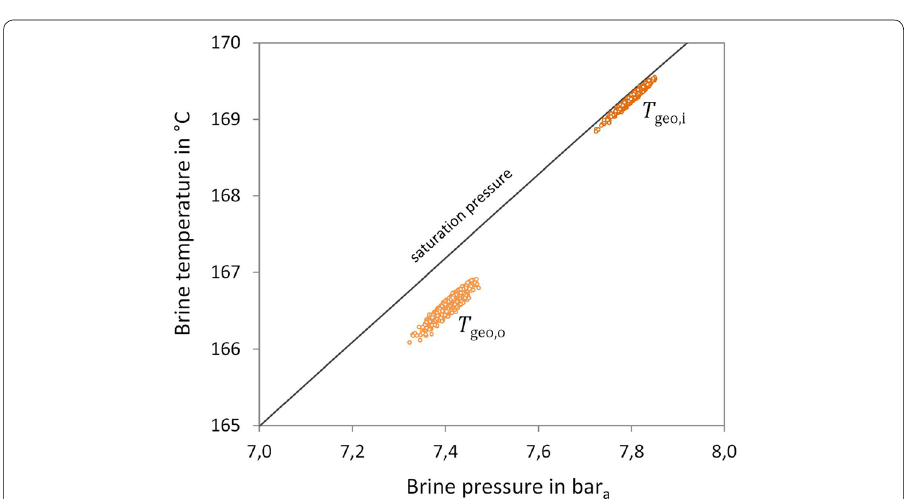
Fig. 9 Plant data for 48 h operation—brine supply temperatures and pressures in relation to the saturation pressure of